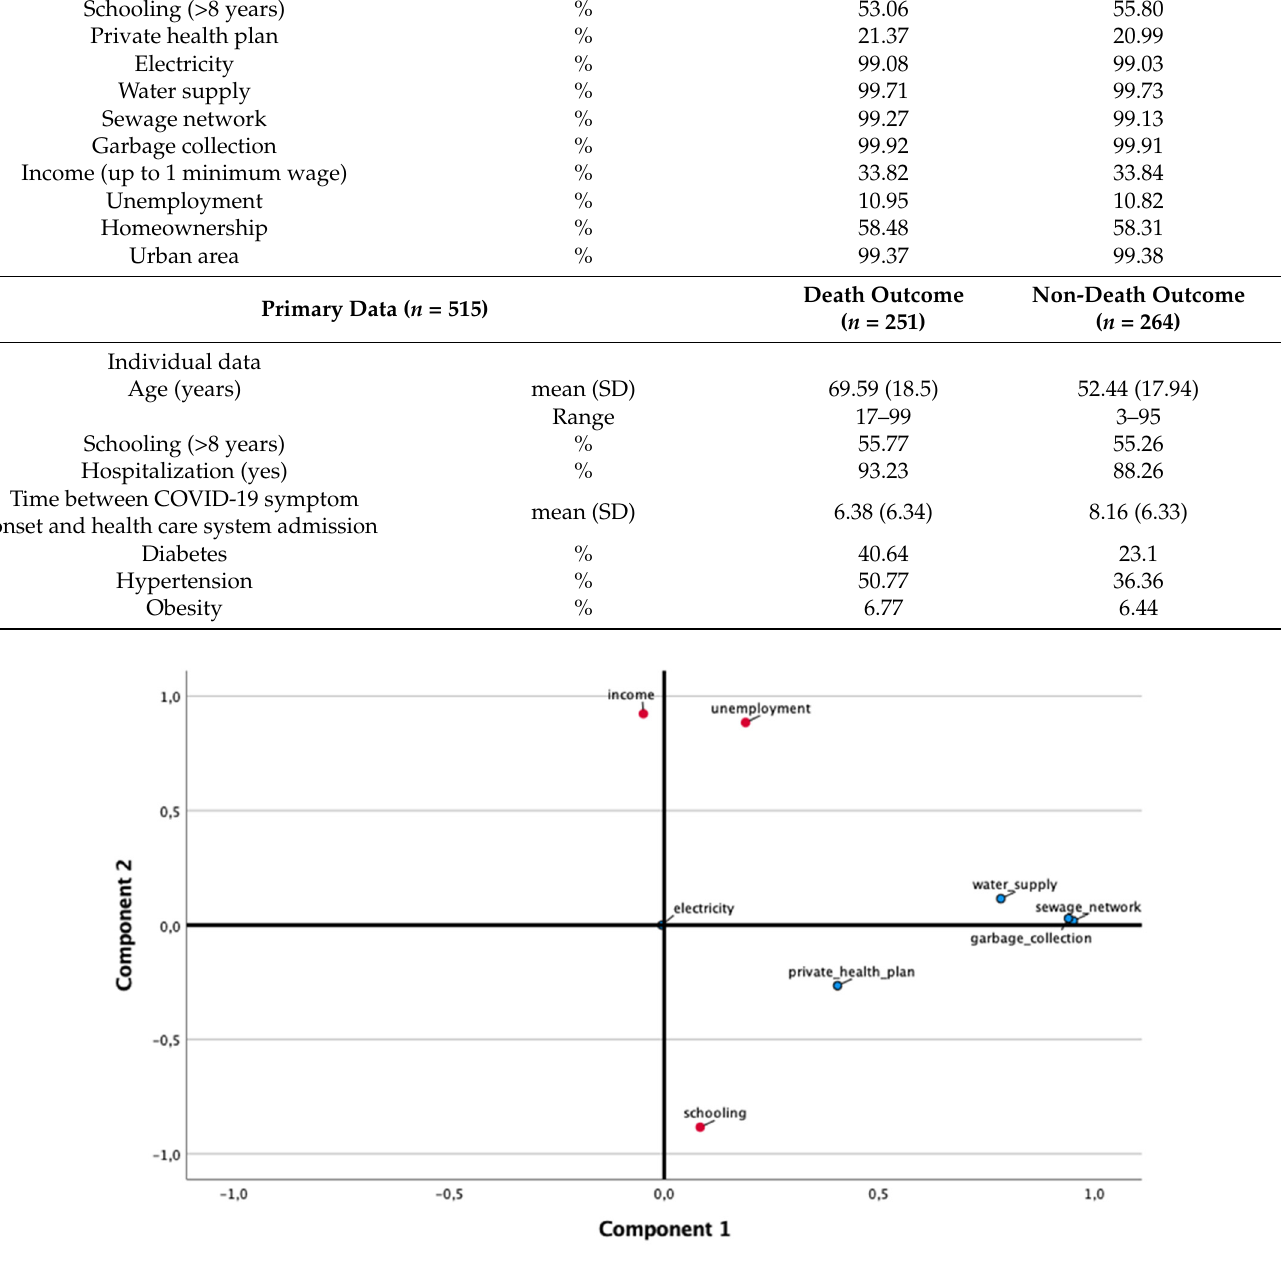
Figure 1. Component plot in rotated space. Component 1: environmental aspects (blue); Component 2: social aspects (red) ( x -axis: Component 1 scores; y -axis: Component 2 scores). Table 2. Component loadings obtained by principal component analysis and Oblimin rotation* of the secondary sociodemographic and economic data.